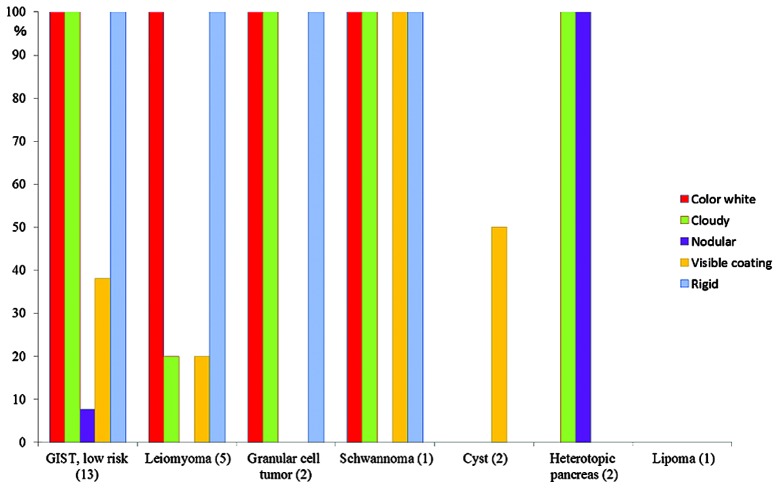
Percentages of each of the five endoscopically visualized features among gastric SMTs. Mesenchymal tumors, including 13 GISTs, five leiomyomas, two granular cell tumors and a single schwannoma, tended to have similar characteristics. Among the SMTs, heterotopic pancreases exhibited small nodules with the appearance of pancreatic tissue. GIST, gastrointestinal stromal tumor; SMT, submucosal tumor.